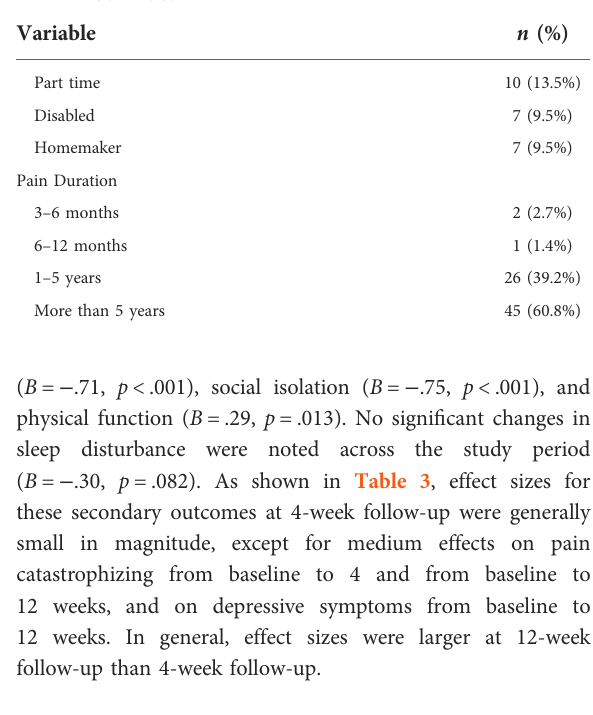
TABLE 1 Baseline sample characteristics ( N =74).